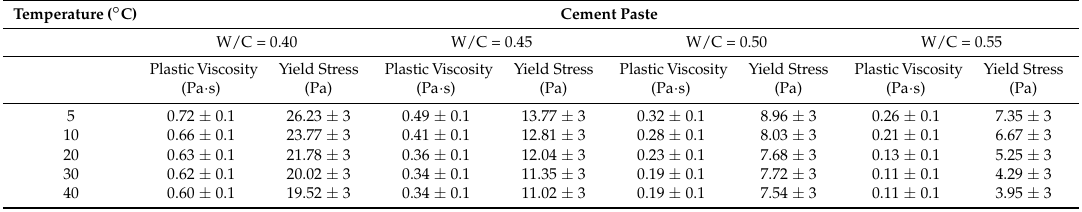
Table 1. The variation of the flow characteristics of cement pastes according to various temperatures. Temperature( ◦ C) Cement Paste W/C = 0.40 W/C = 0.45 W/C = 0.50 W/C = 0.55